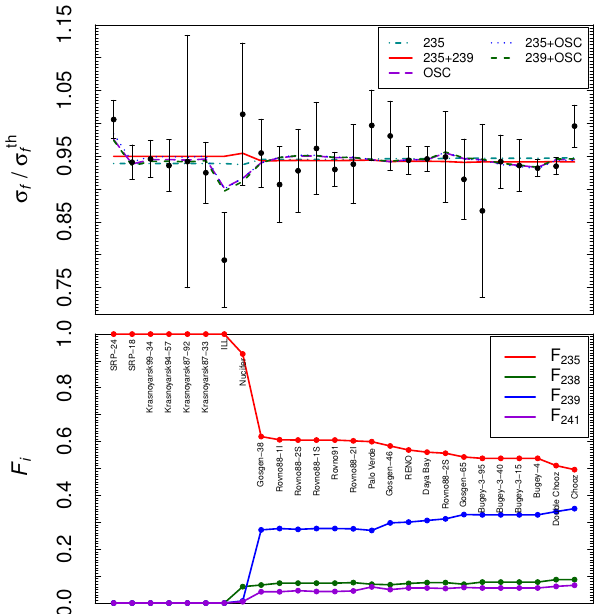
Figure 8 . The top panels show the (cid:12)ts of the reactor rates in table 1 of ref. [12]. The data are ordered by decreasing values of F 235 , shown in the bottom panel. The error bars show to the experimental uncertainties.